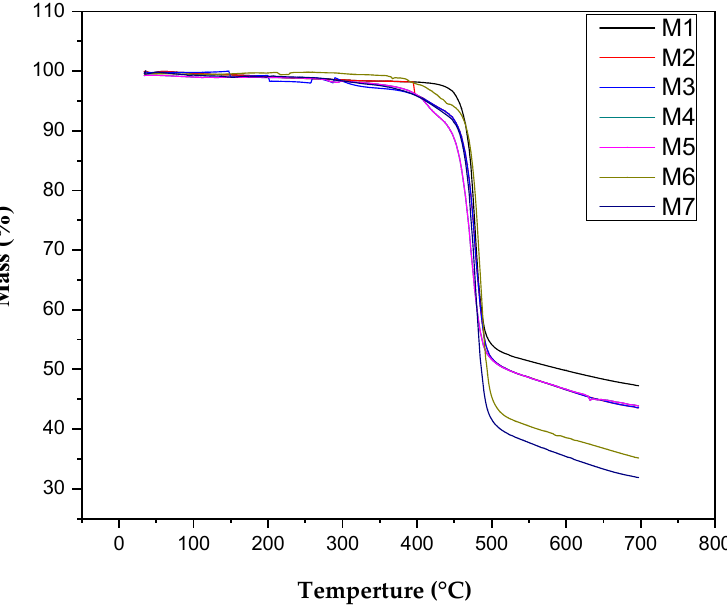
Figure 7. Thermogravimetric analysis of nanocomposite membranes.